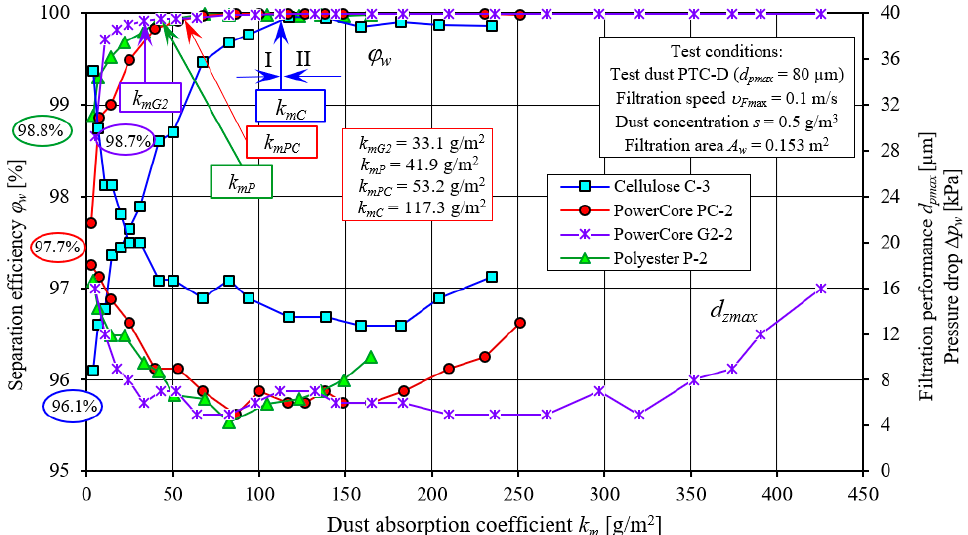
Figure 22. Characteristics of separation efficiency ( φ w ) and filtration performance ( d pmax ) depending on the dust absorption coefficient ( k m ) of the tested PC, G2, C and P filters.